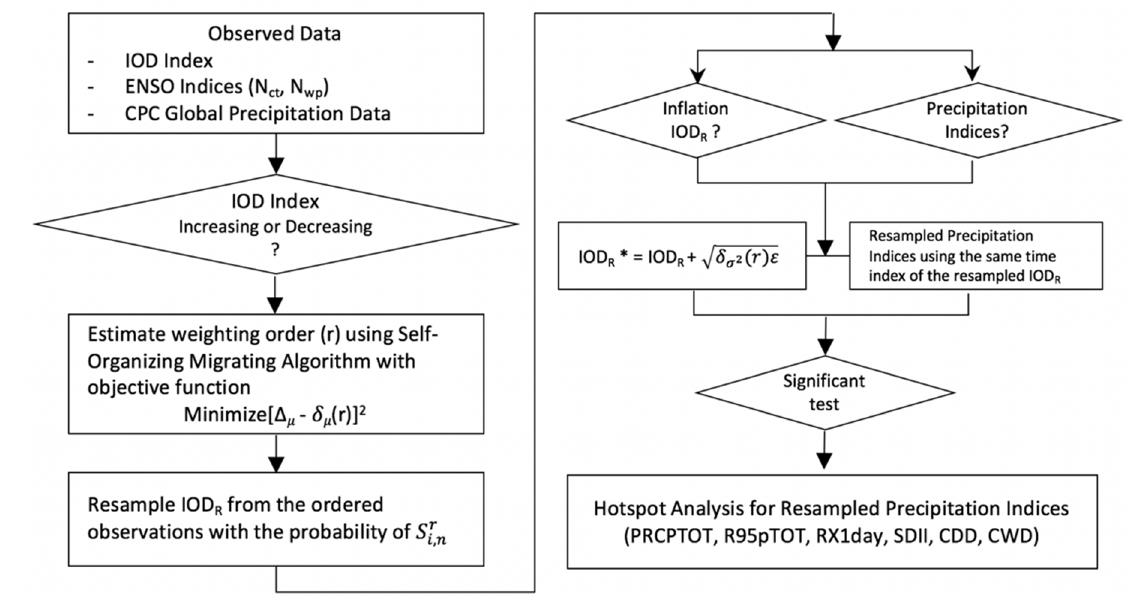
Figure 3. Procedure of the intentionally biased bootstrapping (IBB) resample analysis applied in this study.